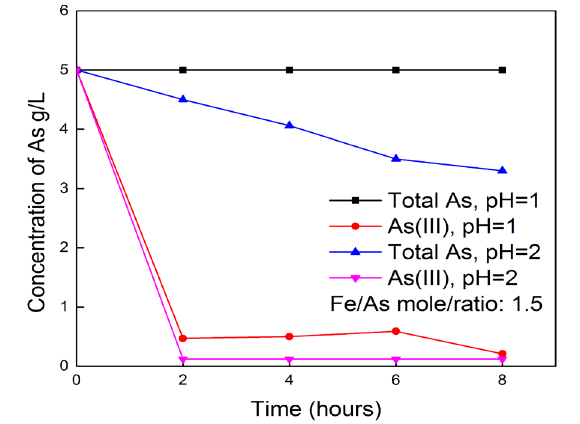
Fig. 5. Effect of Fe 3+ on oxidation of As(III) (5 g/l) (T-90°C)